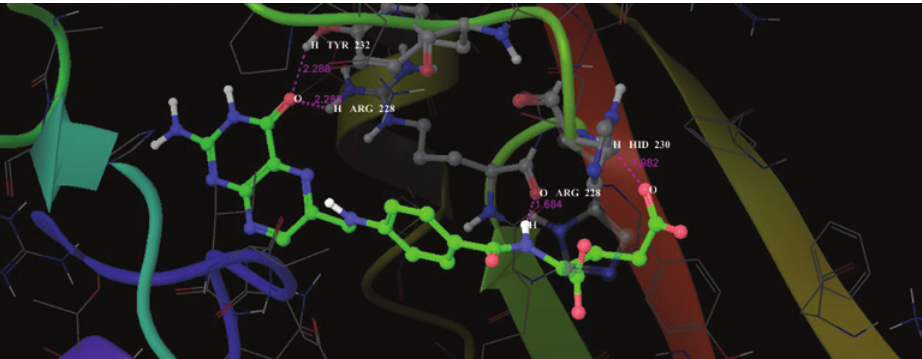
Figure 11: Interaction profile of folic acids and cytosine deaminase in the functional site as ribbon representation.